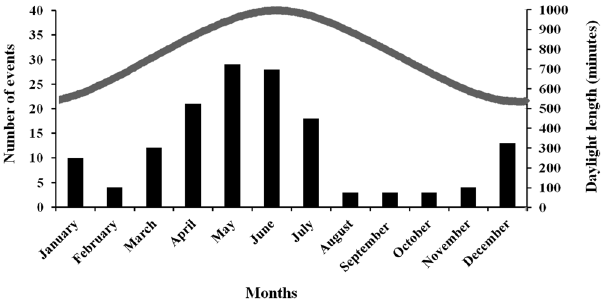
Figure 2. Total number of monthly diurnal motor activity events recorded in the monitored settlement in relation to daylight hours during the year.